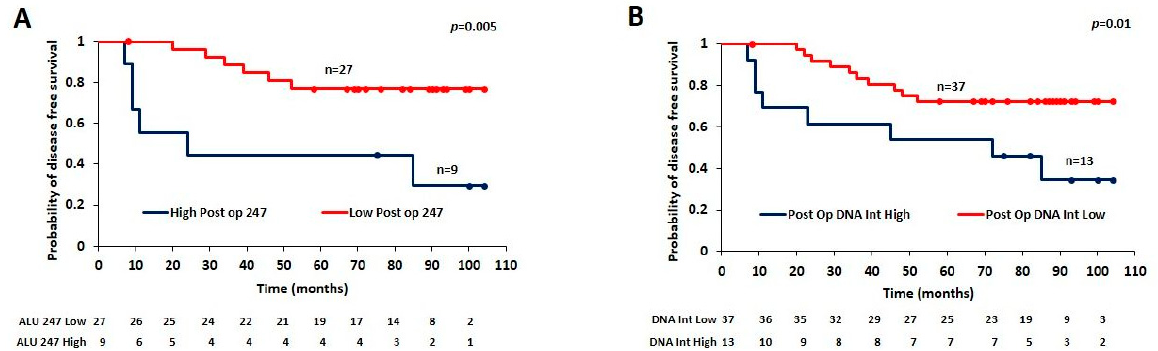
Figure 3. ( A ): disease-free survival between ALU 247 low (n = 27) and ALU 247 high (n = 9) samples and ( B ): between DI low (n = 37) and DI high (n = 13) samples.